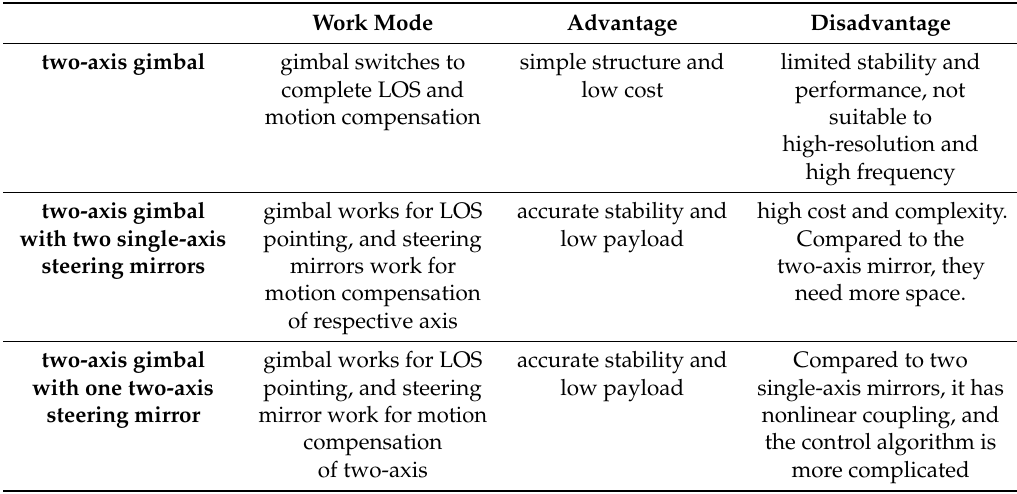
Table 1. Typical architectures for line of sight (LOS) and motion